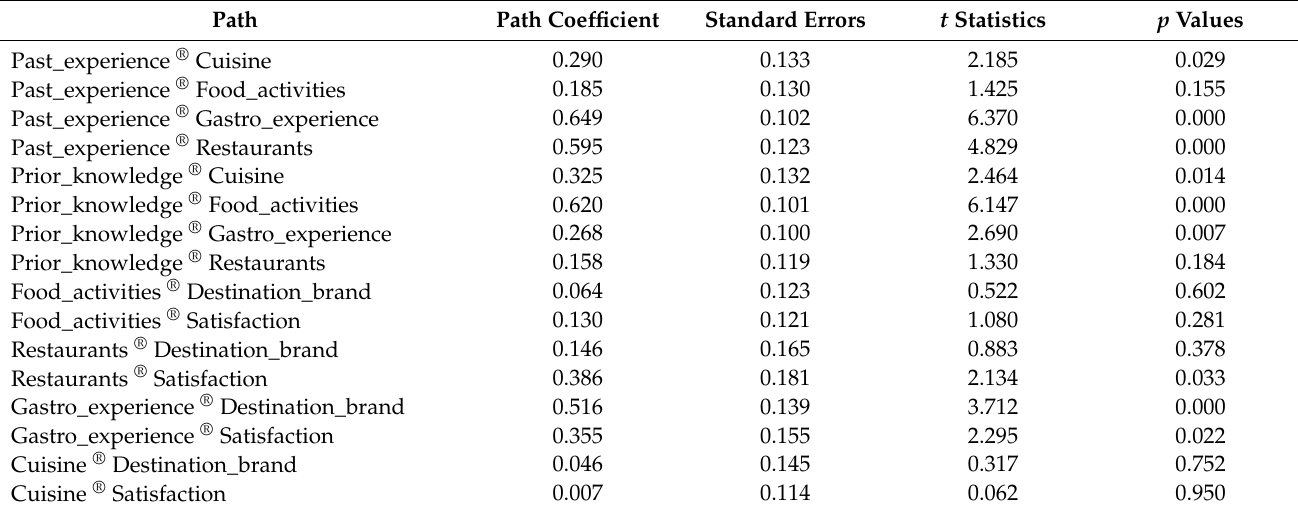
Table 4. Structural model